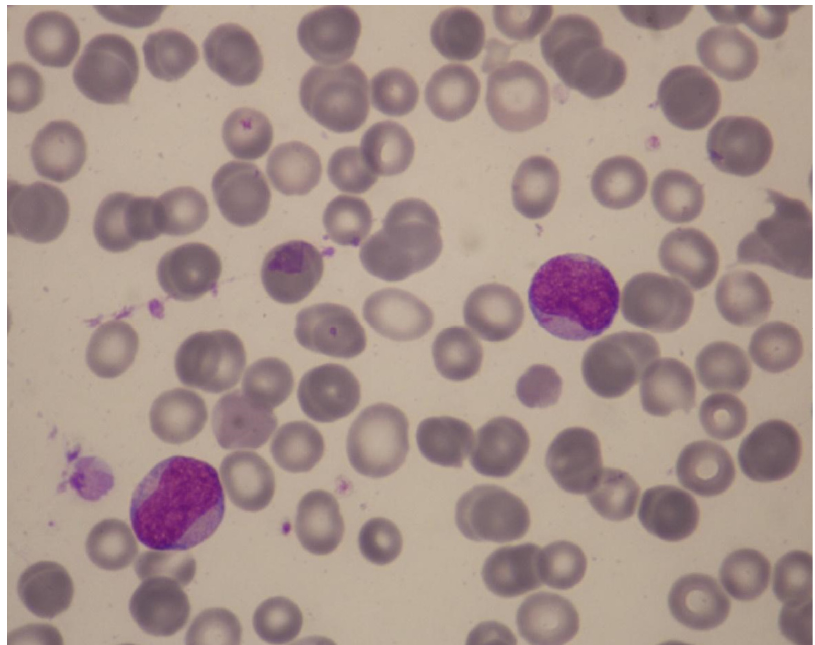
Figure 5. Illustrative case of t-AML. A 49-year-old woman was referred because of neutropenia and thrombocytopenia of 2 months’ duration that were found on routine tests. Four years previously, she had been treated for Churg–Strauss syndrome with steroids and intravenous pulse cyclophosphamide 500 mg once per month for 6 months. Her history included cold-agglutinin disease, osteoporosis, and anxiety with coexisting depressive disorder. Her medications included low-dose prednisolone and azathioprine. The hemoglobin was 14.0 g/dL, white-cell count 9140/ µ L (neutrophils, 820/ µ L), MCV 86.6 fL, and platelet count 58,000/ µ L. May-Grünwald-Giemsa staining of a peripheral-blood smear revealed 58% blasts with Auer rods, easily identifiable under oil immersion ( × 1000) (Figure). Bone marrow examination demonstrated a moderately cellular marrow with 38% leukemic blasts expressing CD34 partial , CD117, CD13, CD33, and HLA-DR. A diagnosis of AML without maturation was made. She had a normal karyotype and an exon 12 NPM1 mutation without FLT3 -ITD or other lesions on a targeted NGS panel. How should she be treated? Recommendation: The patient has t-AML post cytotoxic/immunosuppressive therapy with an alkylator (cyclophosphamide) and antimetabolite (azathioprine). The type of t-AML induced by cyclophosphamide is usually preceded by MDS which then progresses to overt AML. Our patient’s 2-month history of neutropenia and thrombocytopenia is not sufficient to document preceding t-MDS (according to the minimal diagnostic criteria for MDS, persistent cytopenia lasting for ≥ 4 months is required for a diagnosis of MDS). Her disease is classified according to ELN as “AML with mutated NPM1 , therapy-related”. She belongs to the ELN favorable-risk group. Important considerations for definitive therapy in this patient include prognosis of her original non-malignant disease and possible complications from the original disease or previous treatments. Additional work-up showed ejection fraction 55%, oxygen saturation 96%, and slightly diminished lung volumes on a chest CT scan. Therefore, she was deemed fit for intensive chemotherapy. She received “3 + 7” chemotherapy and went into CR. Her clinical course was complicated by neutropenic fever, soft-tissue infection, and platelet- transfusion refractoriness due to platelet HLA alloimmunization. She was found to have a 40- year-old, fully matched sibling donor. ELN suggests HCT in CR1 for fit patients with t-AML who have poor or intermediate risk genetic features. Our patient belongs to the favorable group and therefore we did not refer her for HCT. The treatment plan included a second cycle of anthracycline- cytarabine chemotherapy, followed by three cycles of consolidation with intermediate-dose